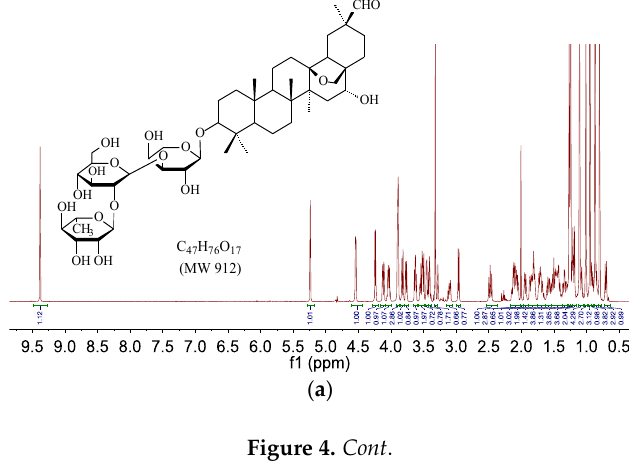
Table 1. The chromatography and mass spectrometry data of ADS-I and its